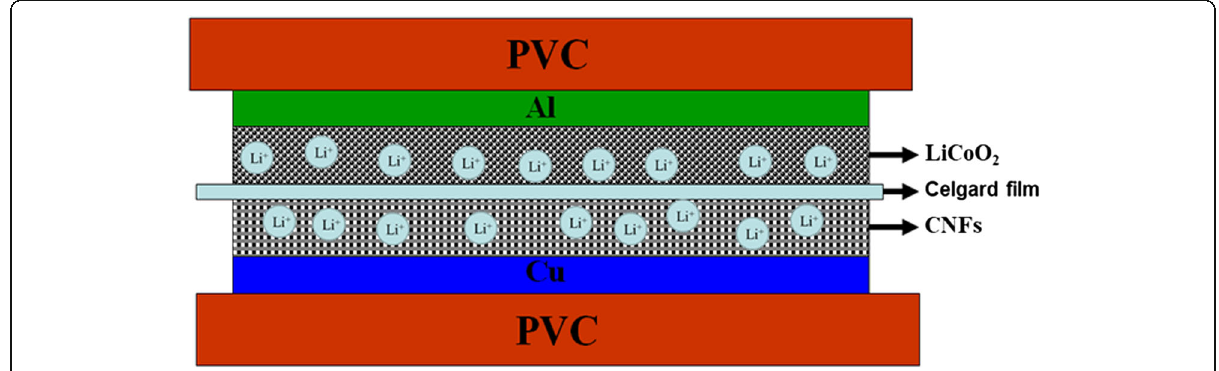
Fig. 1 Schematic illustration for the inner structure of the flexible thin-film